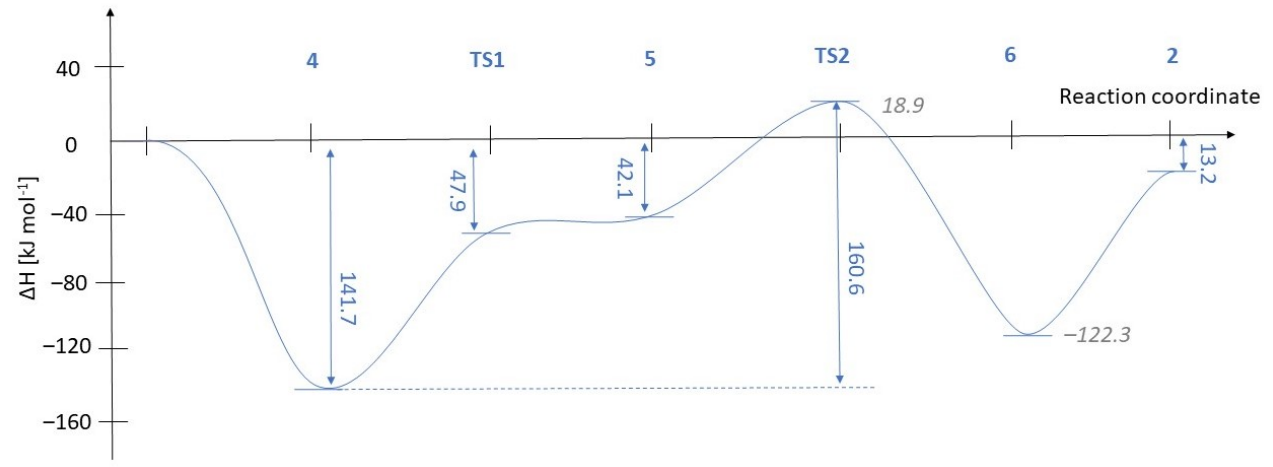
Figure 1. Enthalpy diagram for the direct monoesterification of ethylphosphonic acid ( 1B ) with BuOH.